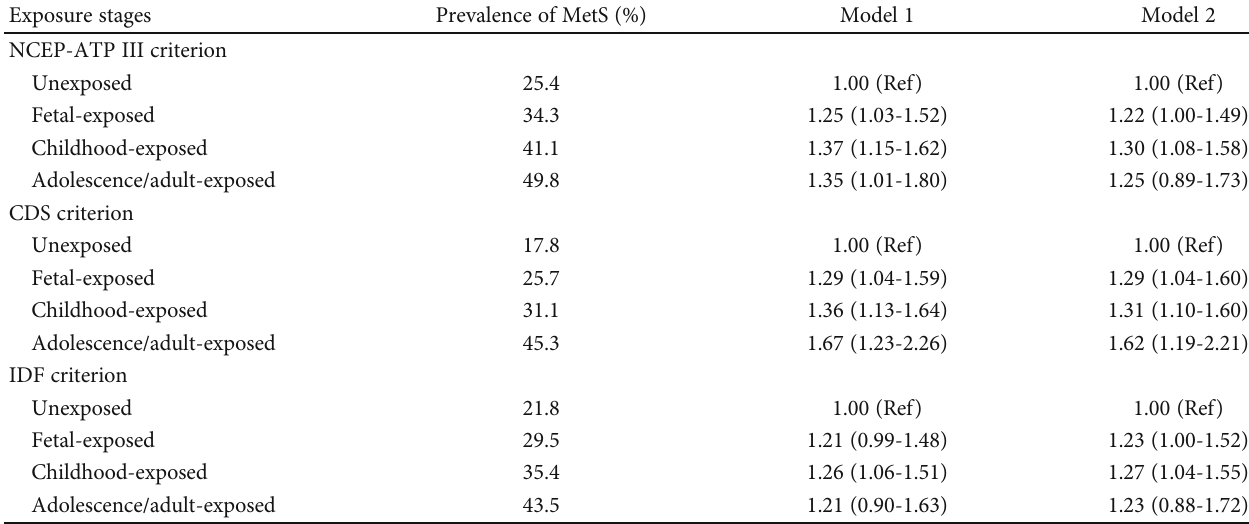
Table 3: Odds ratio (95% con fi dence interval) of metabolic syndrome in relation to di ff erent life stages at famine exposure.